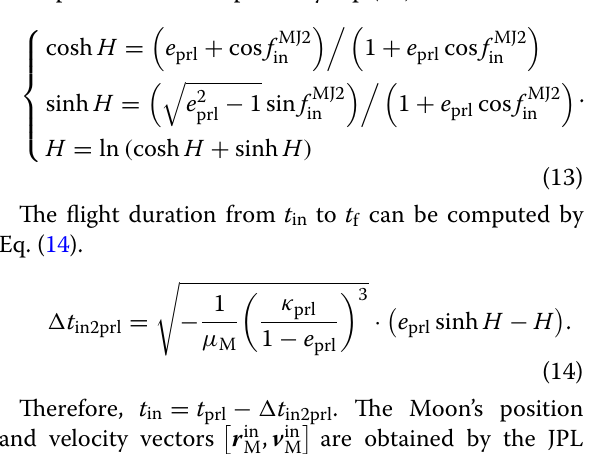
ephemeris table. The position and velocity vectors of the trans-lunar